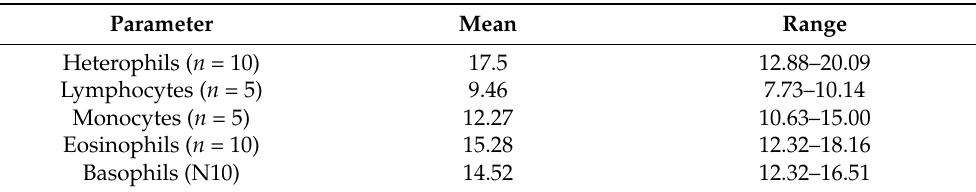
Table 2. Mean ( µ m) and range ( µ m) of leukocyte cell measurement in both male and female captive false gharial ( n =